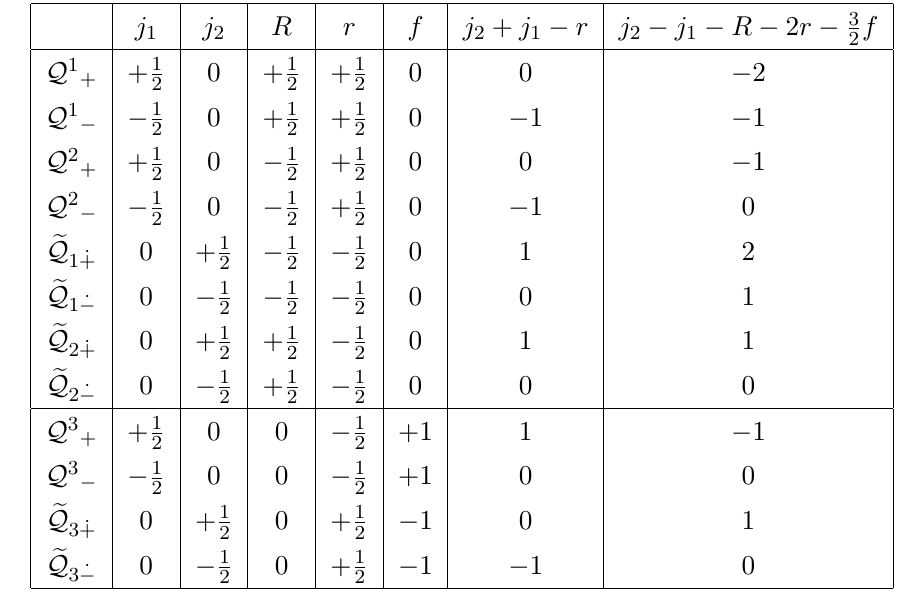
Table 1 . Quantum numbers of